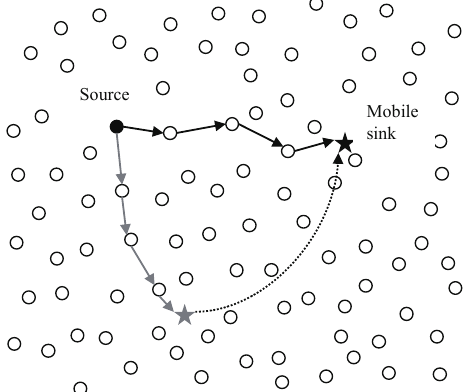
Figure 4. Data dissemination route before and after the mobile sink